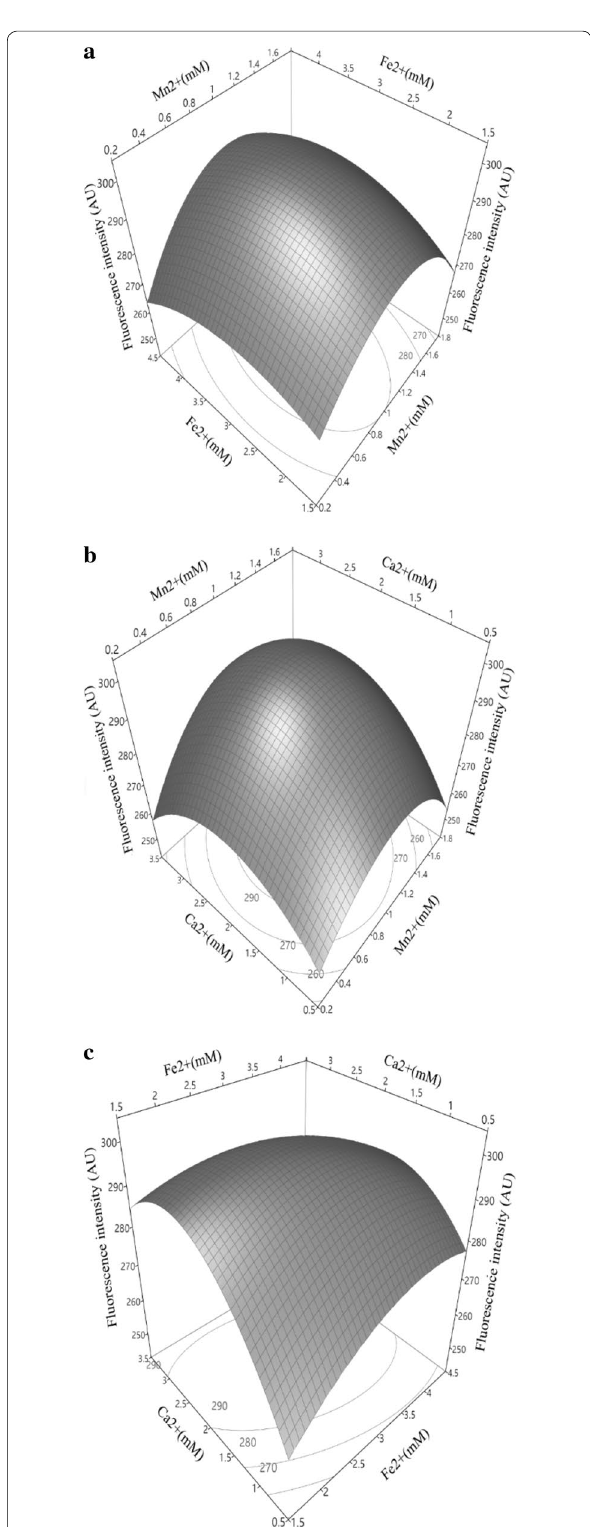
Fig. 2 Response surface plots for spore production caused by metal ions. The interaction between a Mn 2 + and Fe 2 + , b Fe 2 + and Ca 2 + , c Mn 2 + and Ca 2 + , respectively